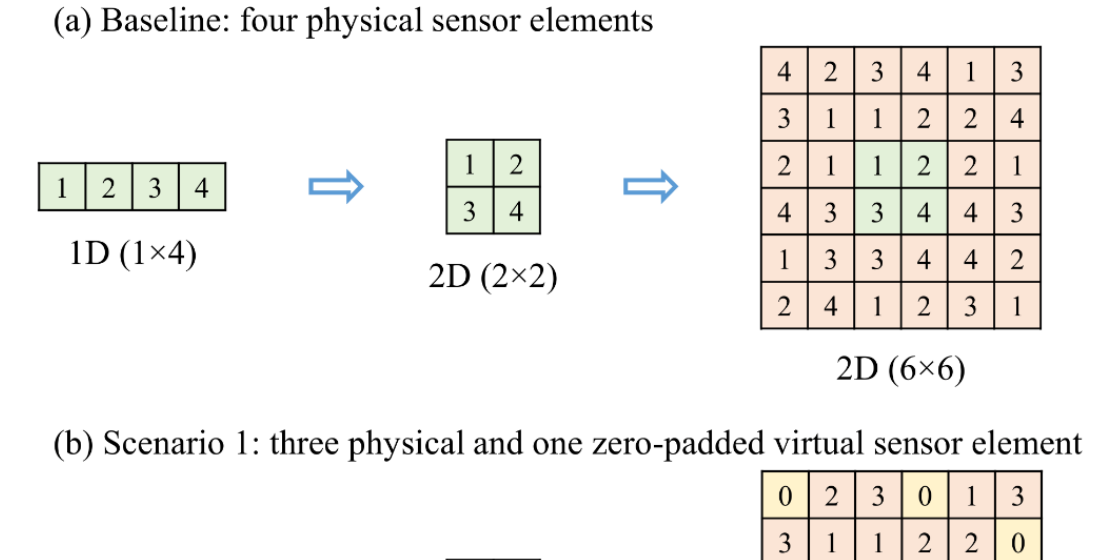
Figure 4. Further details on spatial augmentation using mirror mosaicking can be found in [29,34]. The generalized algorithm for spatial augmentation implementation is presented in Algorithm 1.